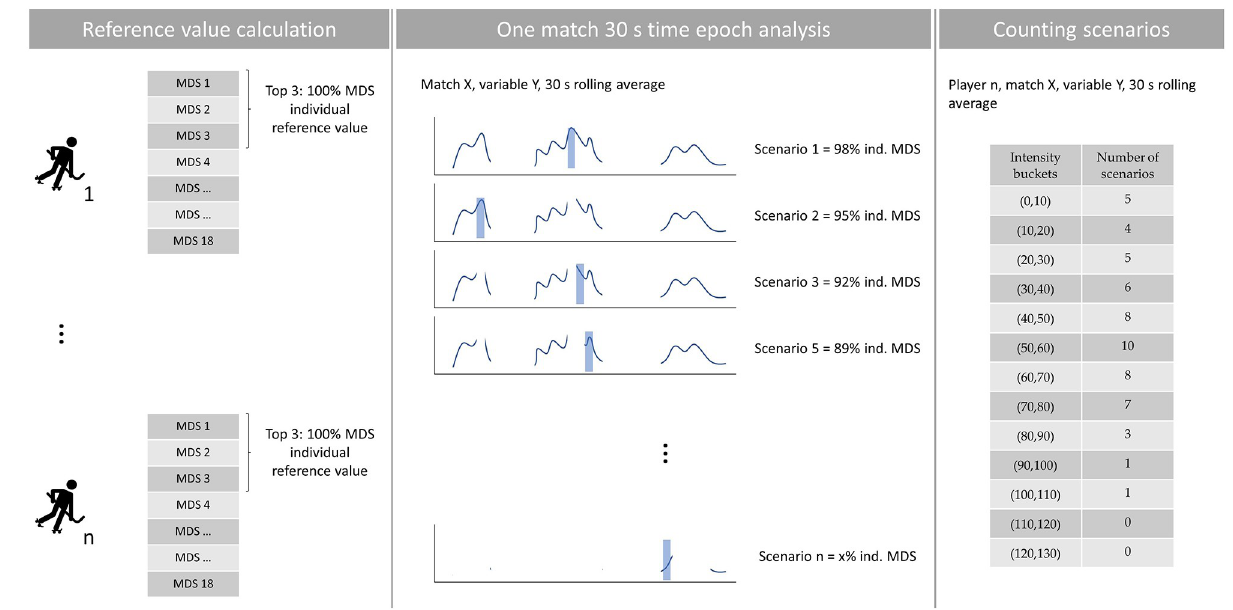
Fig 1. Brief schematic representation of methodological procedures used to calculate: The individual reference values (left panel), all the scenarios in one match (central panel), and how the scenarios are counted (right panel). Abbreviations—MDS: most demanding scenario.